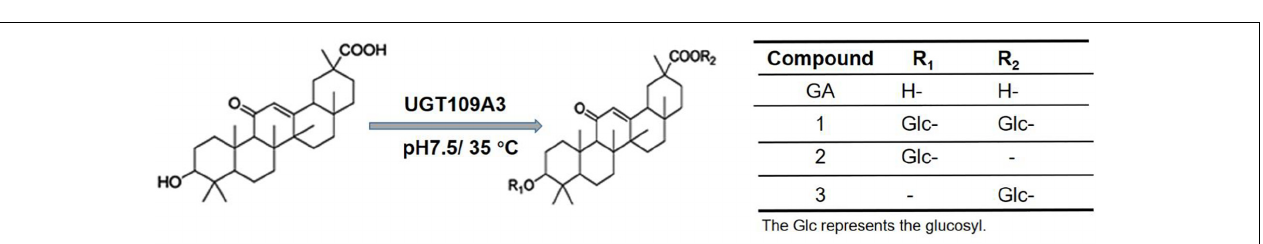
FIGURE 3 | Chemical structure of GA and respective glycosylated